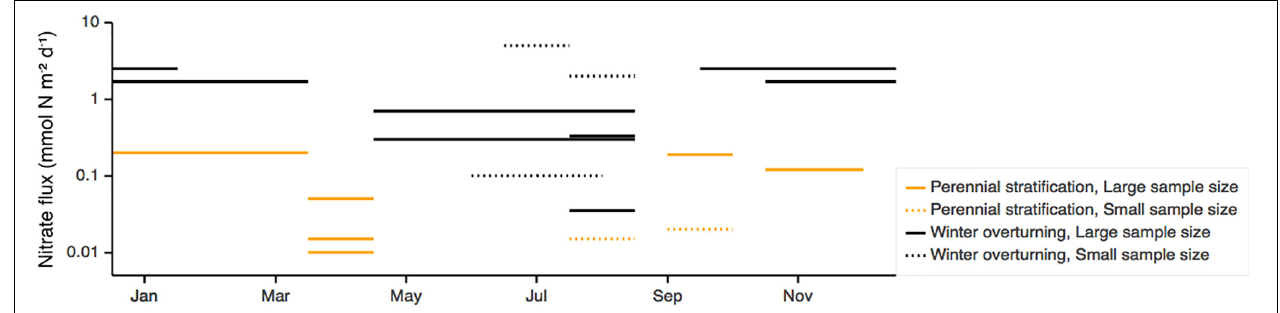
FIGURE 3 | Vertical turbulent nitrate fluxes as a function of the month. Black lines mark the regions where the water column overturns in winter and orange those where it does not. Dotted lines reflect flux estimates based on small sample sizes (N), potentially not very representative of the regional or seasonal scale, whereas solid lines indicate data that are representative of a larger spatial or temporal scale.